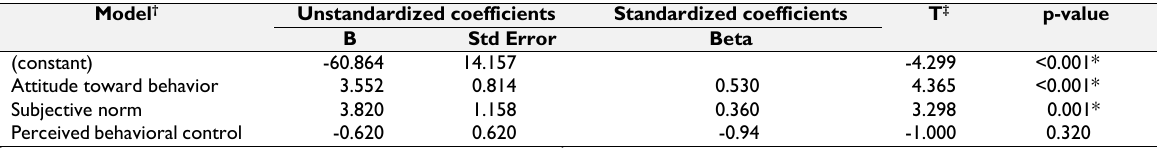
Table 4 Multiple linear regression (N = 100) Model †